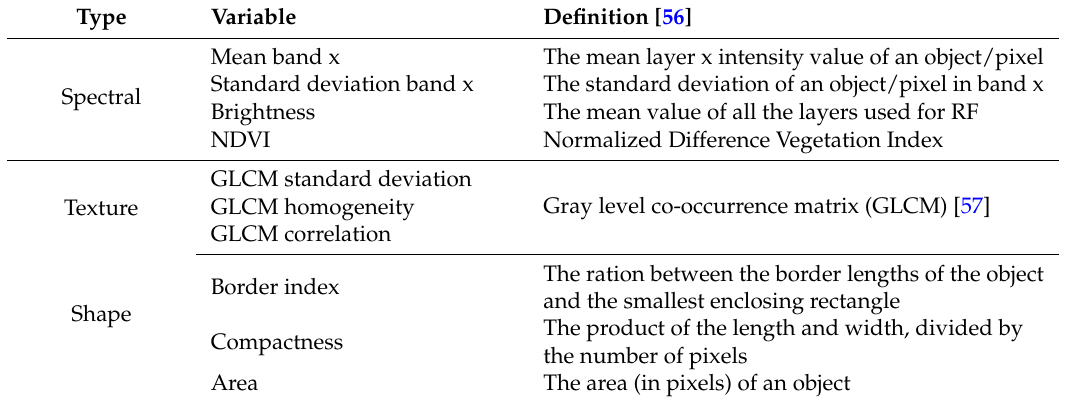
Table 4. Overview of object attributes used in random forest (RF), as exported from the eCognition Developer